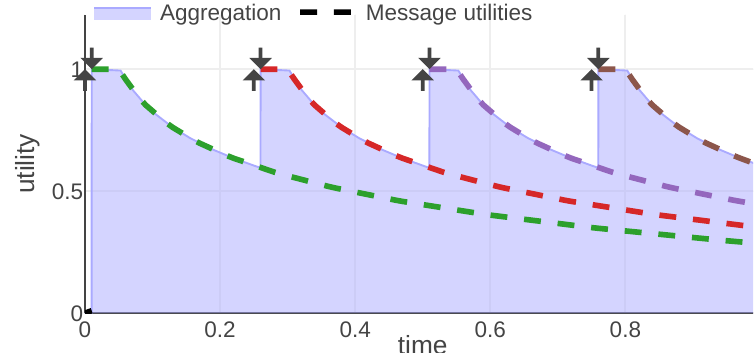
Figure 10. A vid and U vid functions plotted for a video streaming mission